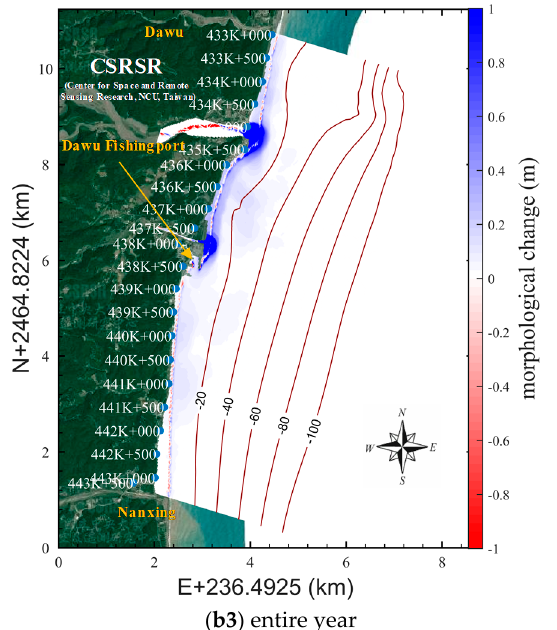
Figure 22. Simulated coastal current and morphological change in Region A. ( a ): coastal current; ( b ): morphological change.